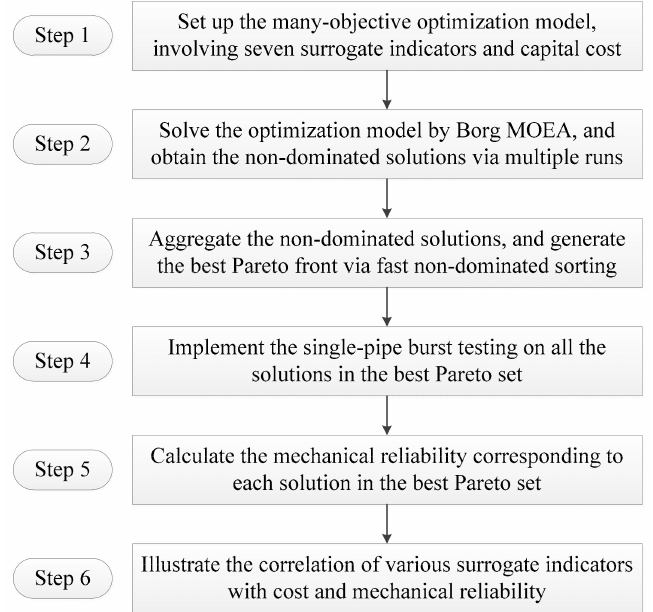
Figure 1. Flowchart of the proposed